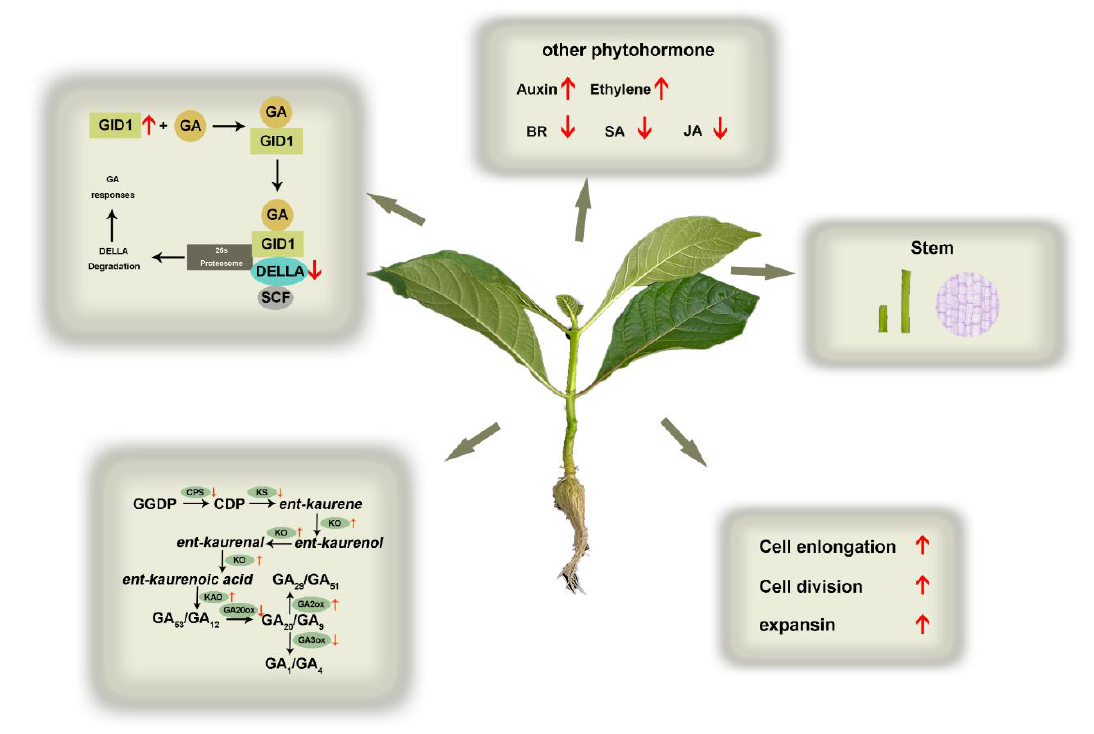
Figure 10. A hypothetical model of the effects of GA treatment on the physiological and molecular mechanisms of N. cadamba . Phenotypes and transcriptome changes in the second internode of GA treatment are indicated by the red arrows. Red arrows indicate an increase or a decrease in physiological indicators or gene expression.